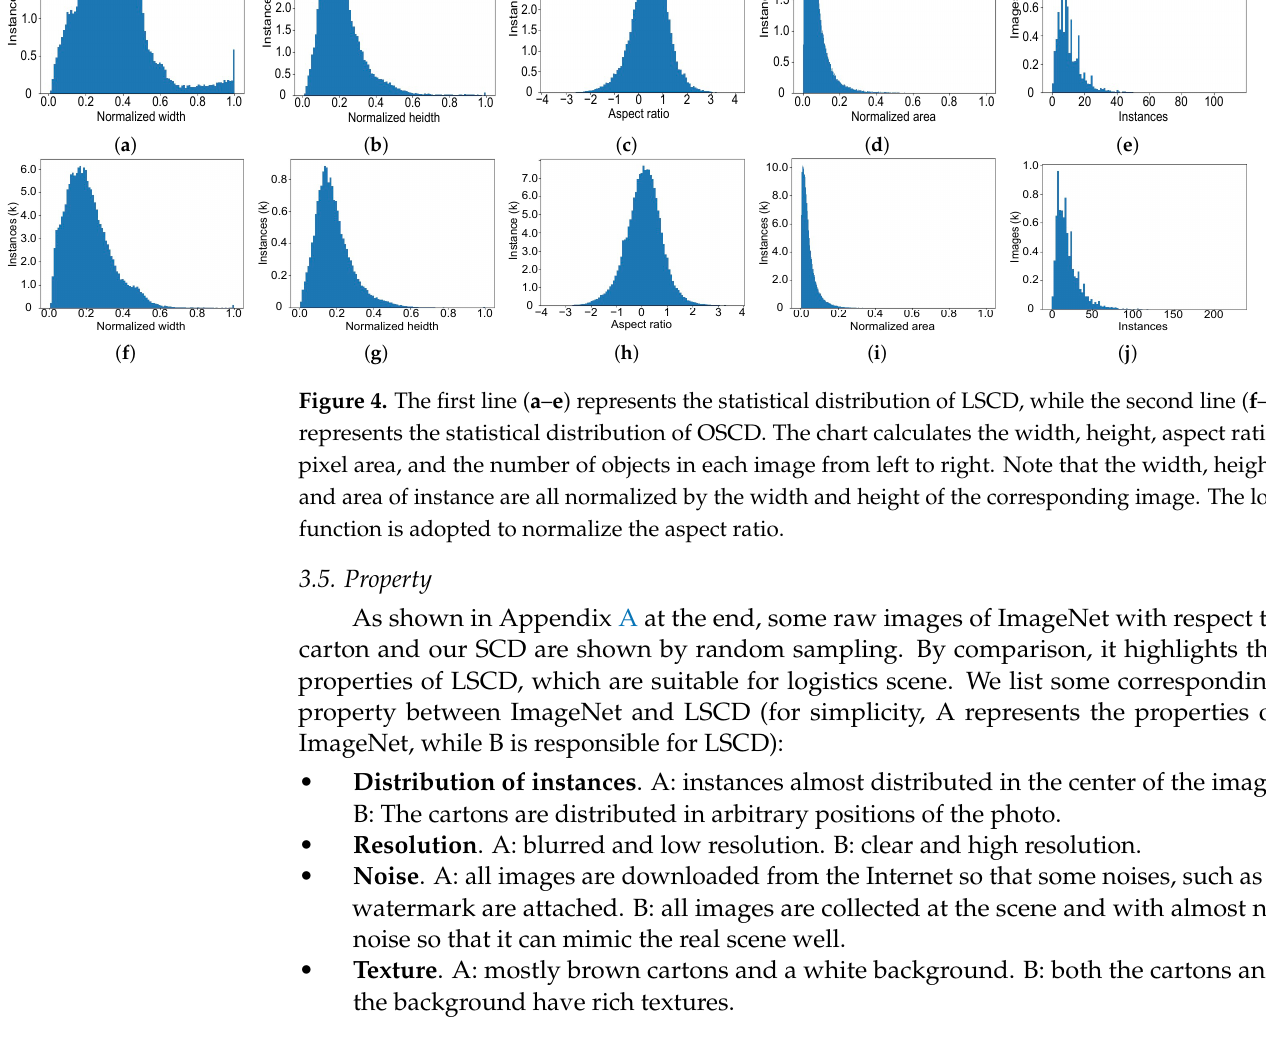
1.00.5 0.0 0.2 0.4 0.6 0.8